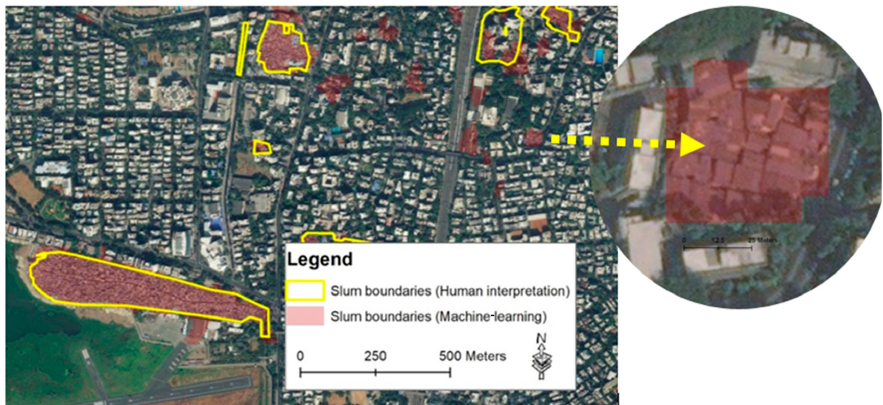
Figure 2. Omission and commission errors comparing human and machine-learning deprived area maps in Mumbai (left), and an example of a small deprived area mapped by the machine-learning-based approach (right) (Source Image: WorldView-2, DigitalGlobe).